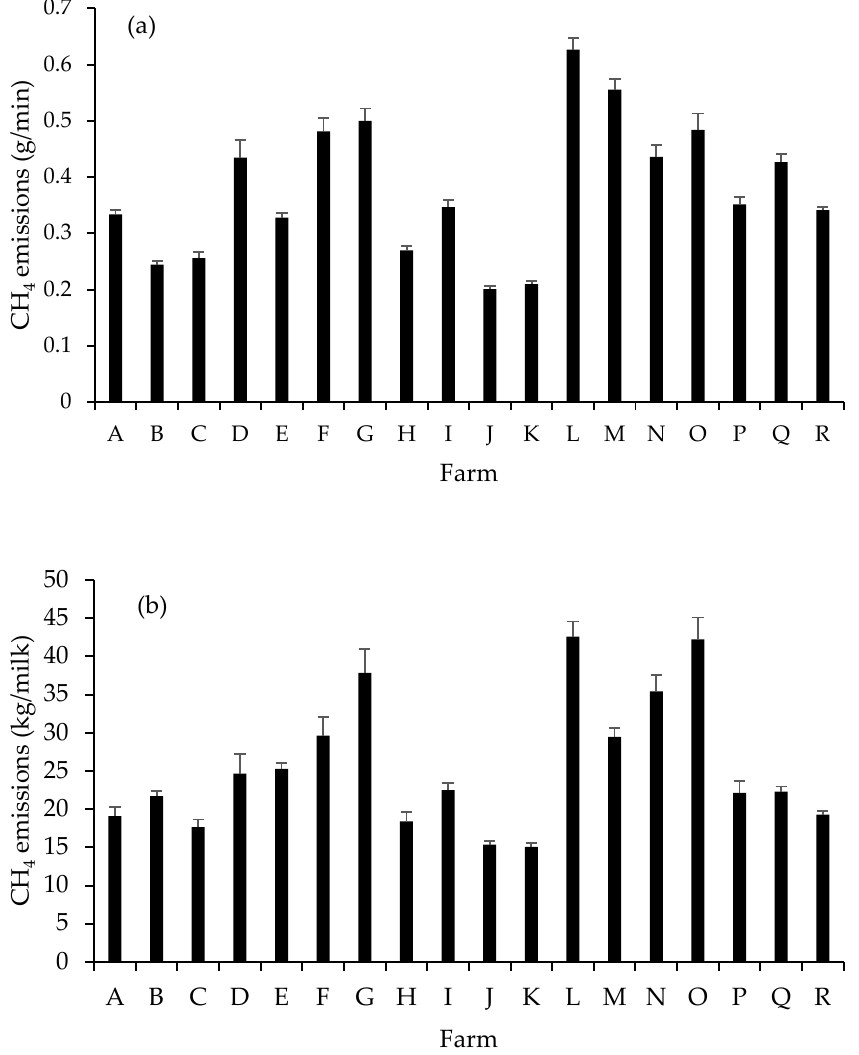
Figure 1. Estimated mean CH 4 emissions (with s.e. bars) in ( a ) grams per minute and ( b ) grams per kg milk for farms A to R.